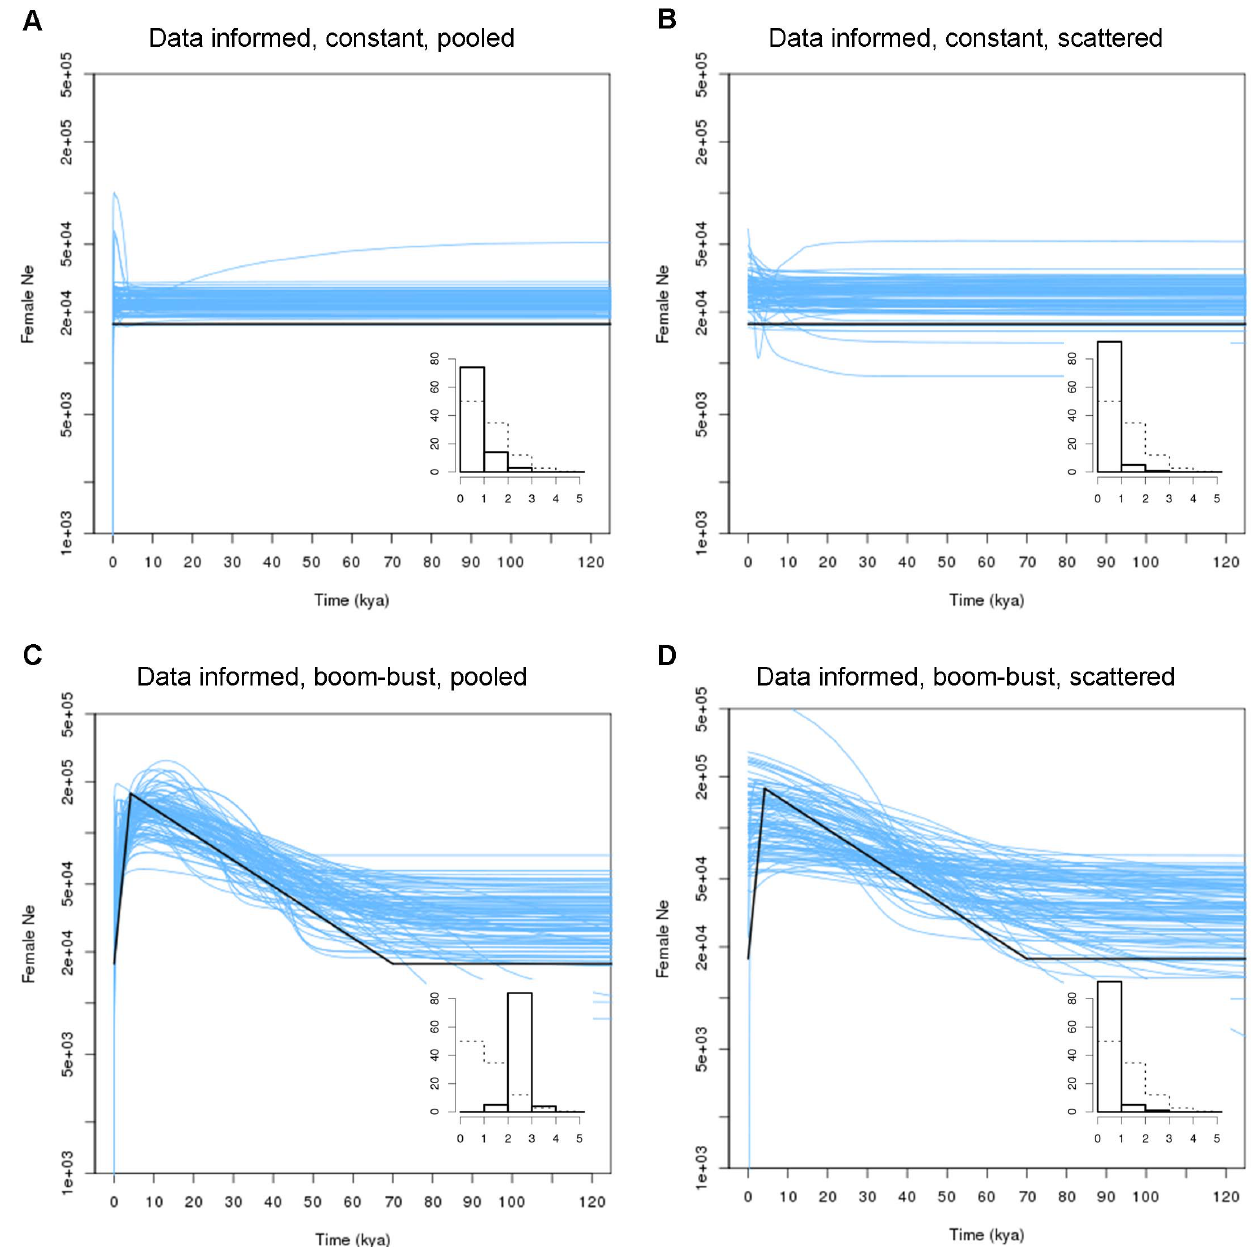
Figure 3. Two demographic scenarios under a real data informed island model. As Figs. 1 and 2, but the island model was modified to conform to the migration matrix estimated for a real biological system, the African buffalo. Only pooled and scattered sampling is shown. Bold lines mark the appropriate simulated population size. Replication was slightly different from Fig. 1 and 2 because it now matters which demes were included in the sample, see main text. Note also that the number of demes was 34, so the sum of the deme size differs from Fig. 1 and 2 (17,000 as opposed to 20,000 females).